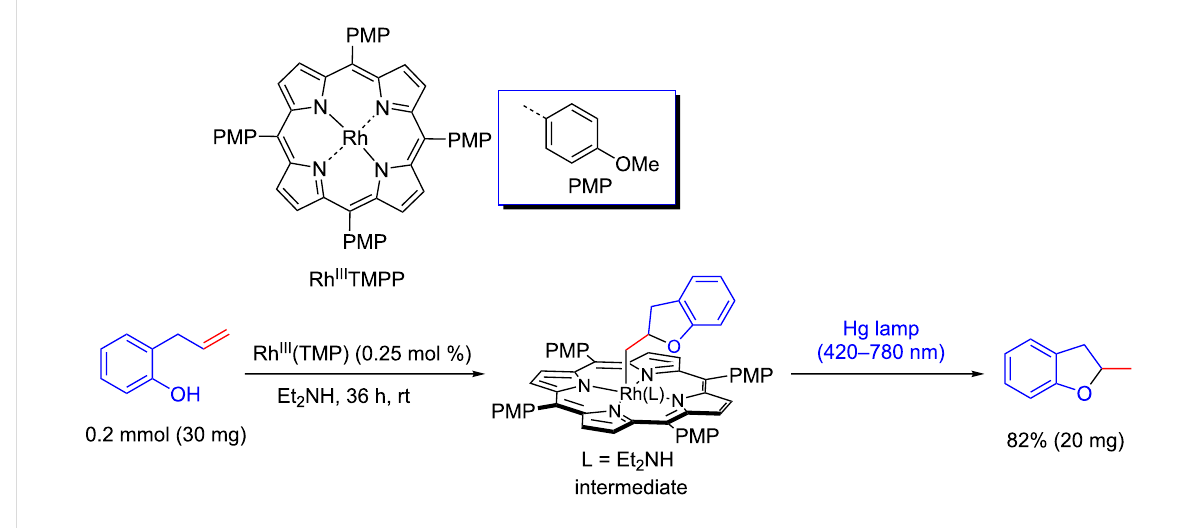
Scheme 14: Formation of 2-methyl-2,3-dihydrobenzofuran by intramolecular hydro-functionalization of allylphenol using Rh III TMPP under visible light irradiation.